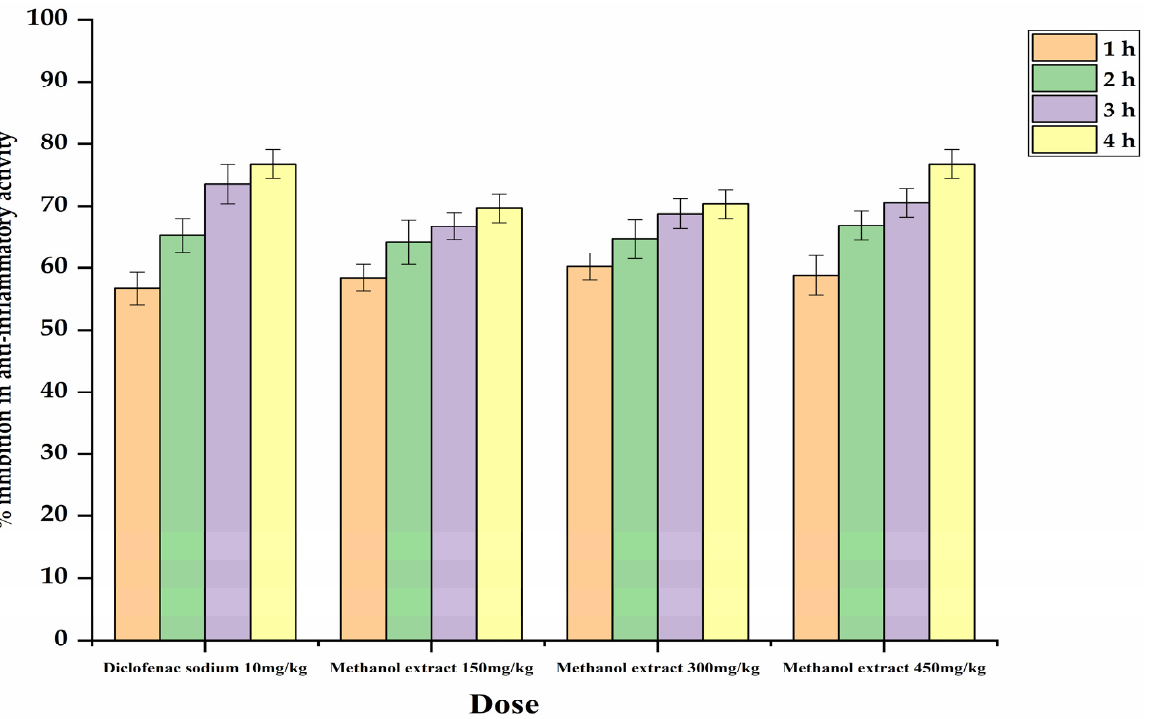
Figure 1. Percentage (%) inhibition in anti-inflammatory potential of different doses of methanolic extracts after 1 h, 2 h, 3 h and 4 h, respectively.